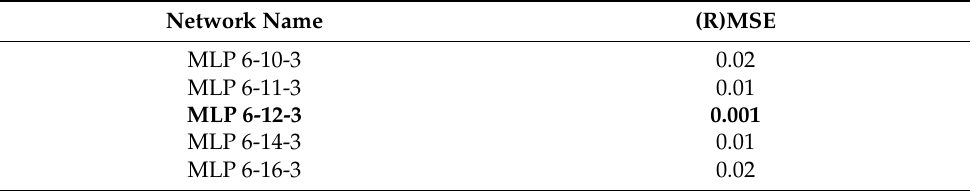
Table 3. MSE values for the best MLP neural